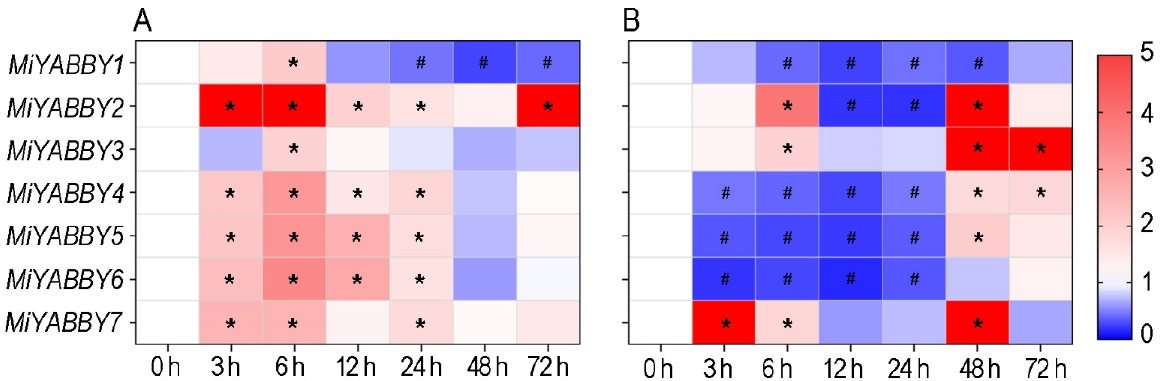
Figure 5. Relative expression analysis of the MiYABBY gene family under different stress treatments in mango. ( A ) shows the results of the PEG treatment, and ( B ) shows the results of the NaCl treatment. The calculation method was 2 −∆∆ CT , and ‘*’ means the value exceeds 1.5, while ‘#’ means the value is below 0.5.